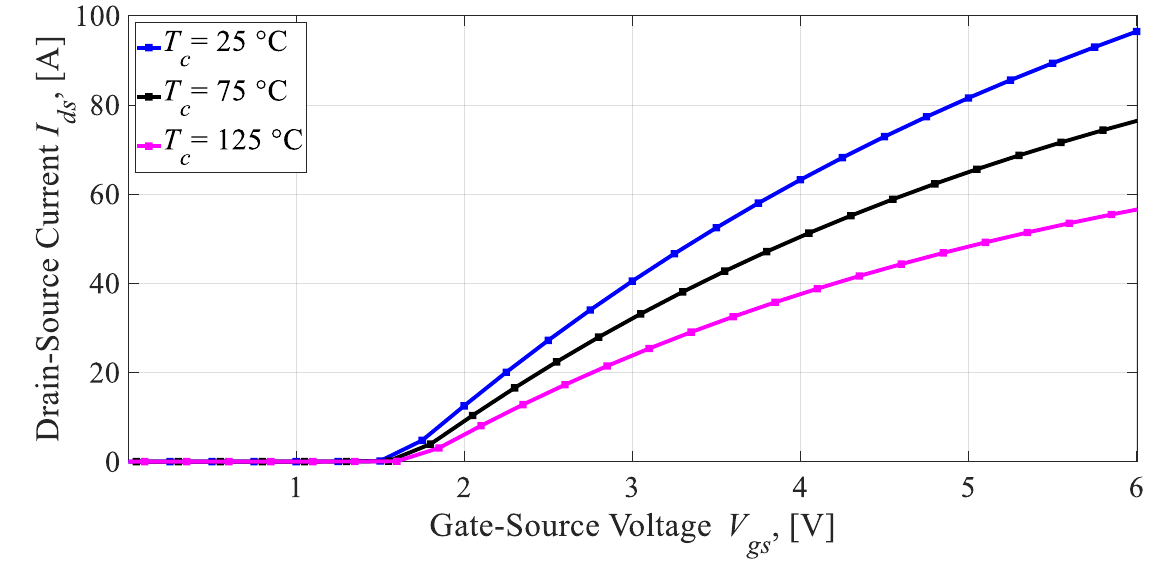
Figure 5. Transfer characteristics measured at different case temperatures.